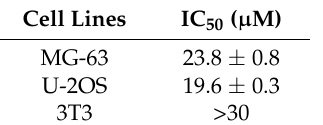
Table 1. The IC 50 value of DK 1 on osteosarcoma cell lines (MG-63 and U-2OS) and normal fibroblast cell line to be used in other assays.